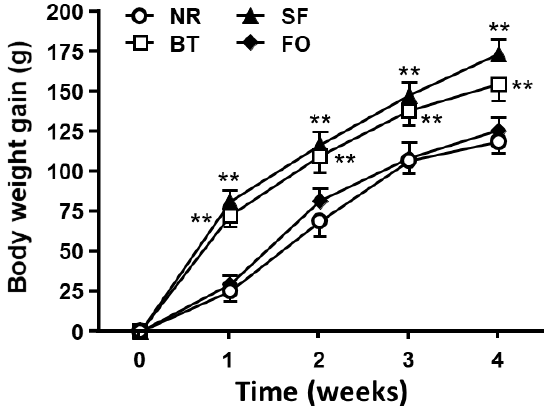
Figure 1. The increase of body weight in rats during 4-week feeding period with either normal rodent diet (NR, 4% fat) or 10% high-fat diets, including safflower oil (SF), beef tallow (BT), or fish oil (FO), respectively. Values are expressed as mean ± SE.; n = 6, ** p < 0.01 vs. FO and NR.